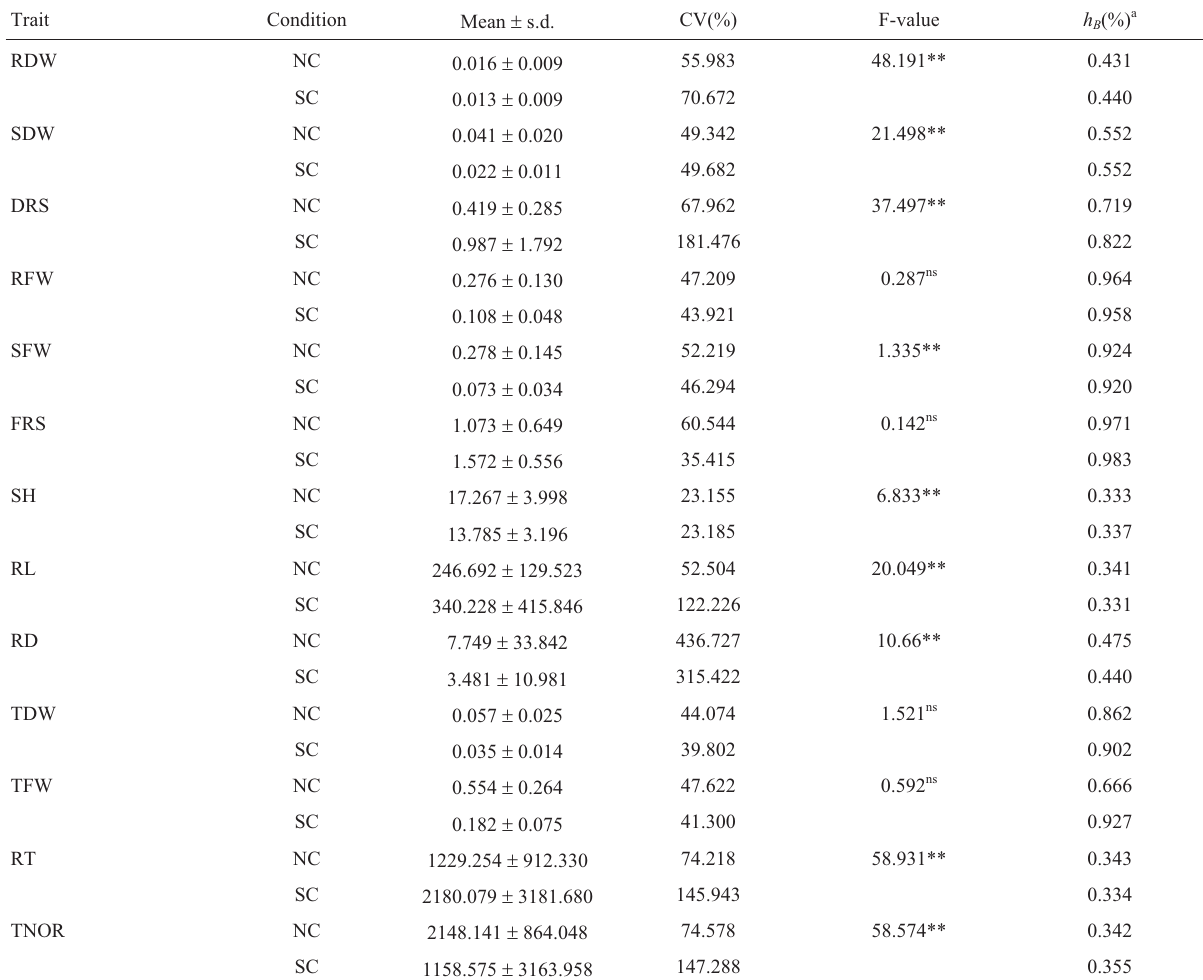
Table 1 - Phenotypic variation in 13 traits in 373 Aegilops tauschii accessions under the normal condition (NC) and the PEG-induced, simulated drought-stress condition (SC).